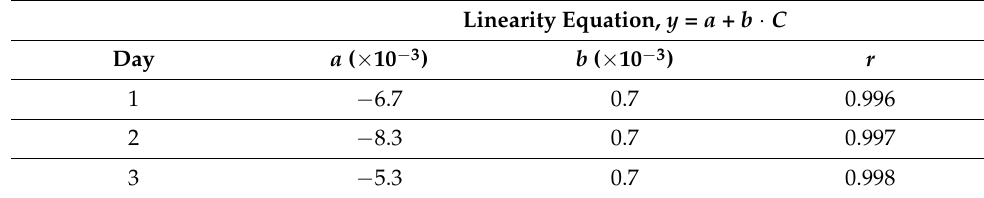
Table 1. Calibration curves